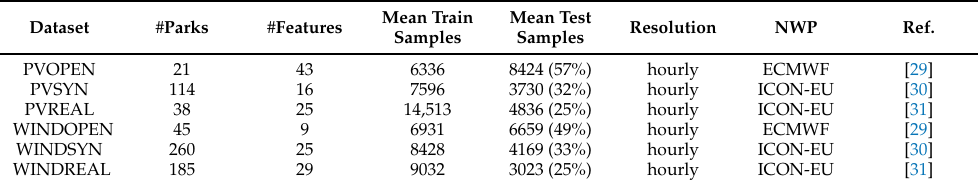
Table 1. Overview of the evaluated datasets. All datasets except PVREAL and WINDREAL are openly accessible.